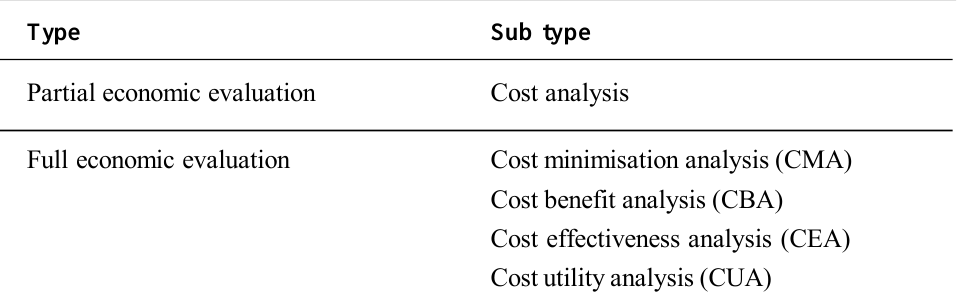
Table 1. Types of economic